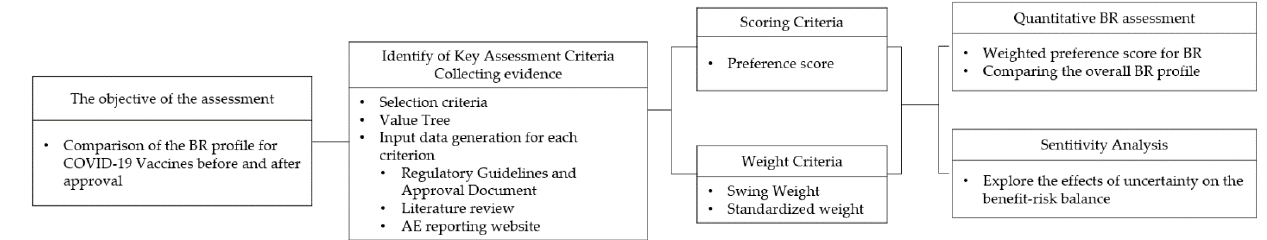
Figure 1. Overview of MCDA process for the benefit-risk assessment model for COVID-19. BR: benefit-risk. MCDA: multi-criteria decision analysis.